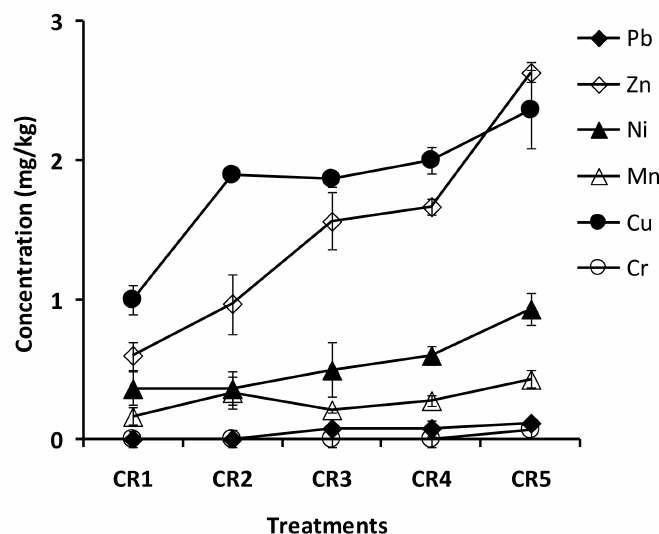
Figure 6. Heavy metal concentrations in the stem of C. cajan . UR: Bars represent means ± standard deviation ( n = 3). UR is an uncontaminated rhizosphere and CR 1 to CR5 represent contaminated rhizosphere with POS from 1 to 5% w / w